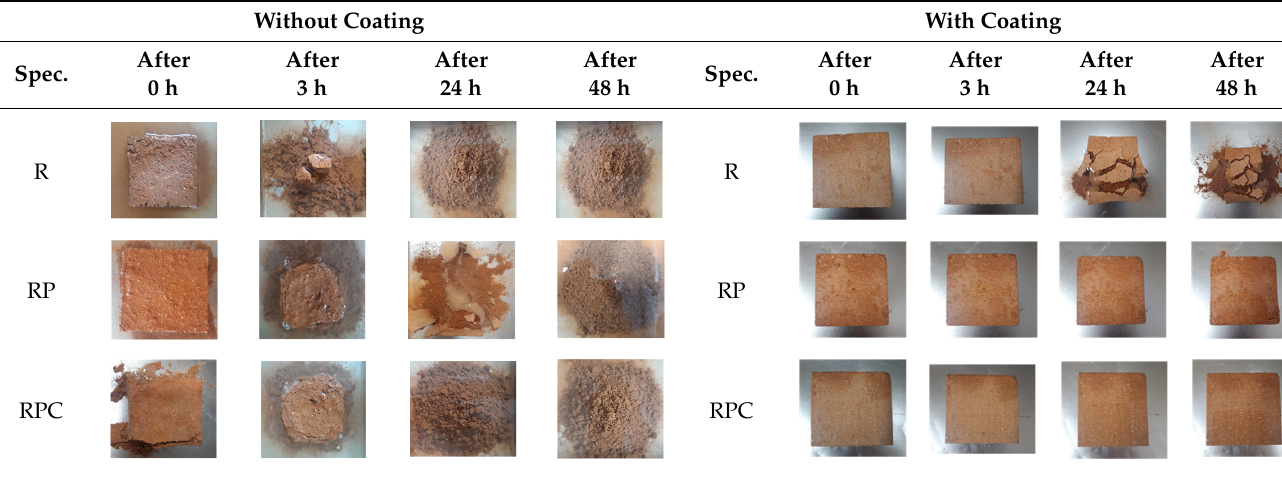
Table 3. Water erosion of the red clay binder specimens.